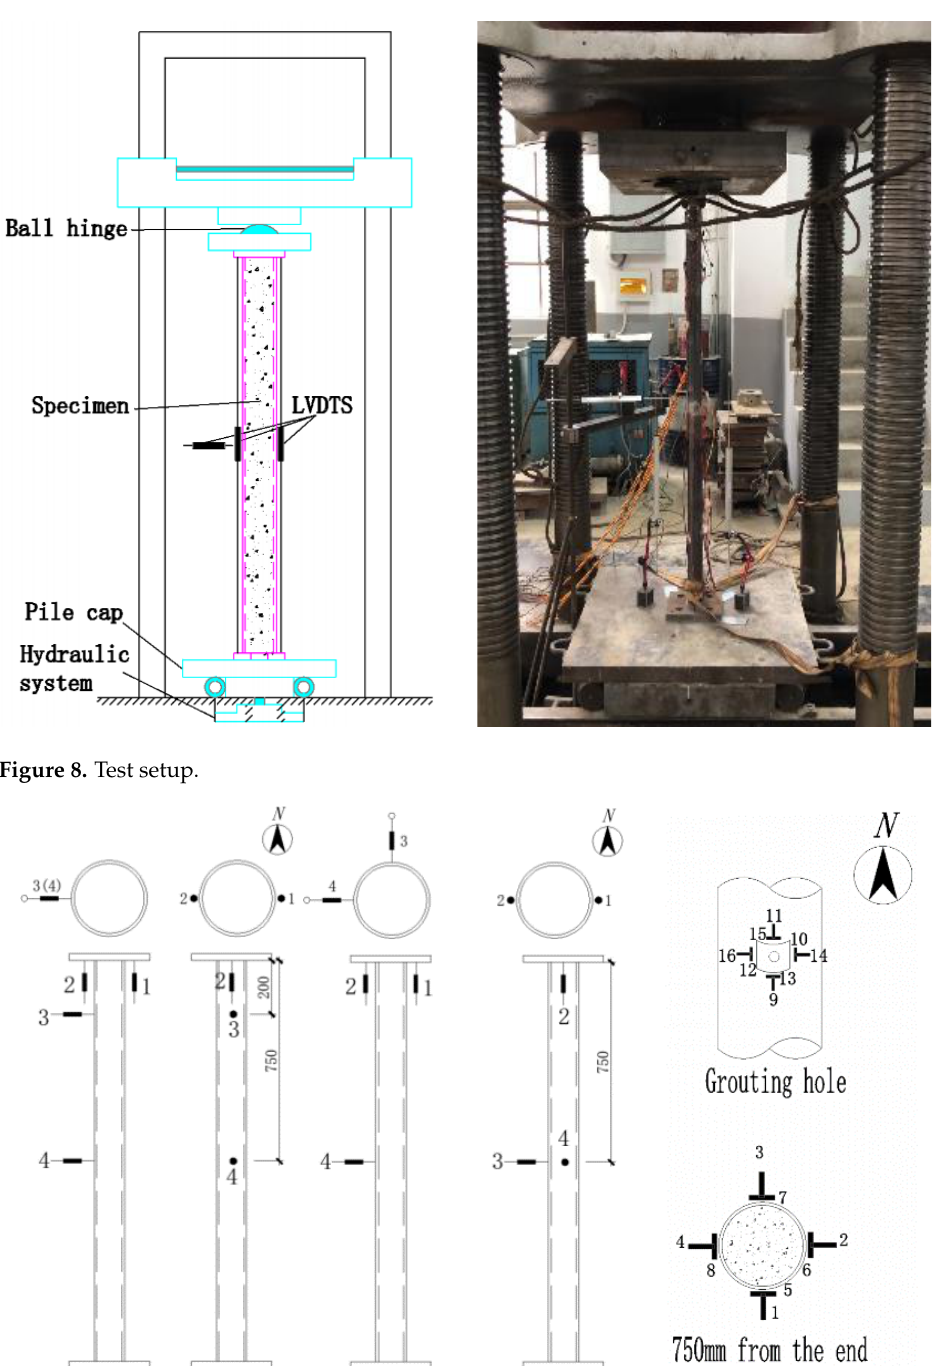
( c ) Figure 7. RPC material sample. ( a ) Compressive; ( b ) Uniaxial compressive; ( c ) Tension. Table 3. Mechanical performance test results of RPC. Cube Strength 𝒇 𝒄𝒖 (𝐍 𝐦𝐦 𝟐 ⁄